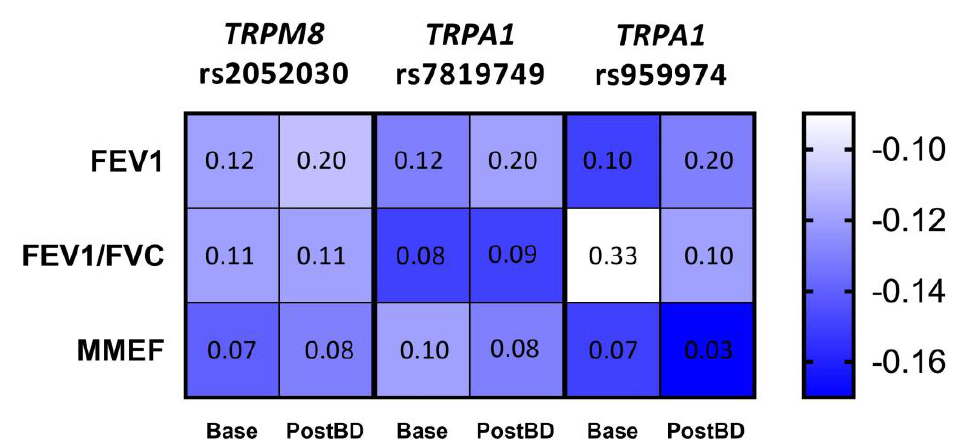
Figure 3. Correlation between the number of risk alleles for TRPM8 rs2052030, TRPA1 rs7819749 and TRPA1 rs959974 polymorphisms and spirometric parameters of the studied COPD patients measured at baseline (Base) and after the inhalation of bronchodilator (PostBD). The values of Kendall’s τ coefficient are color-coded; each cell contains the corresponding FDR p -value.